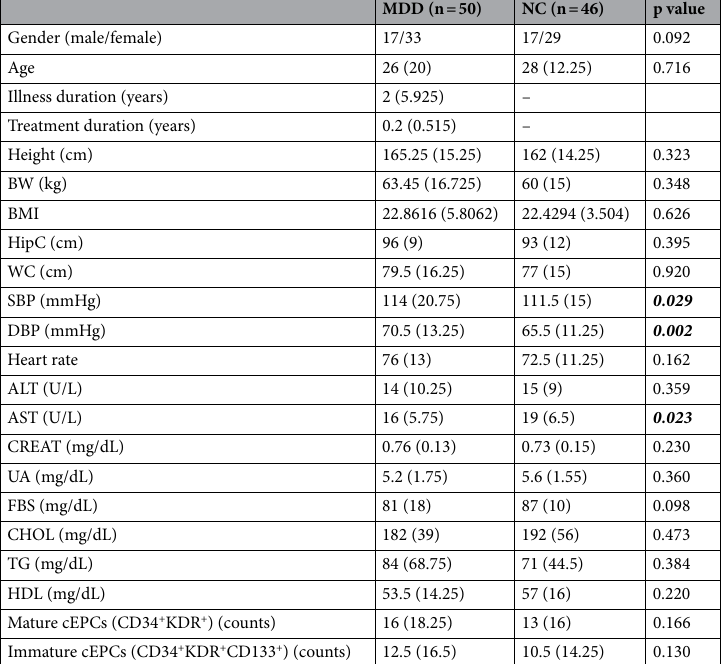
Table 1. Comparison of demographic parameters, clinical measurements, and cEPC counts between patients with major depressive disorder (MDD) and healthy controls (HCs). Bold italicised values represent the p-values less than 0.05. BW body weight, BMI body mass index, HipC hip circumference, WC waist circumference, SBP systolic blood pressure, DBP diastolic blood pressure, ALT alanine aminotransferase, AST aspartate aminotransferase, CREAT creatinine, UA uric acid, FBS fasting blood sugar, CHOL cholesterol, TG triglyceride, HDL high density lipoprotein cholesterol, cEPC circulating endothelial progenitor cells. Continuous variables were presented as their medians and interquartile ranges